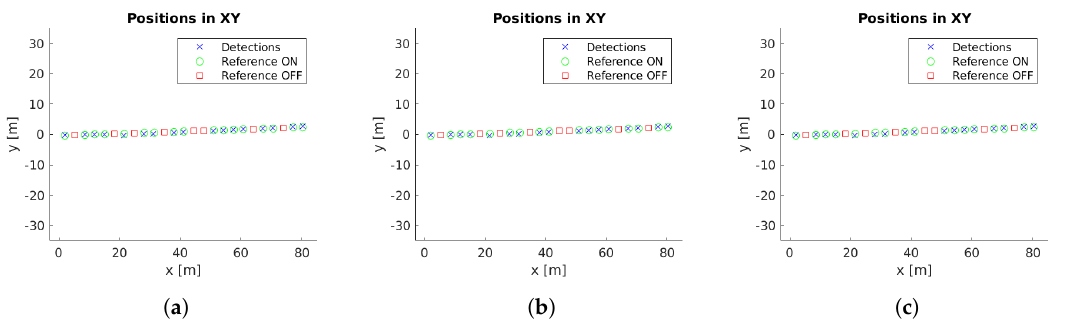
Figure 9. Cluster centers and reference values for case study 4. ( a ) Unconstrained system [31], ( b ) system with reprojection error filtering, and ( c ) system with filtering and orientation alignment..